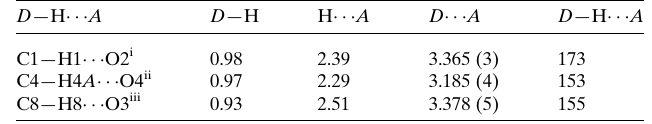
Table 1 Hydrogen-bond geometry (A˚ , (cid:3) ) for 1 .